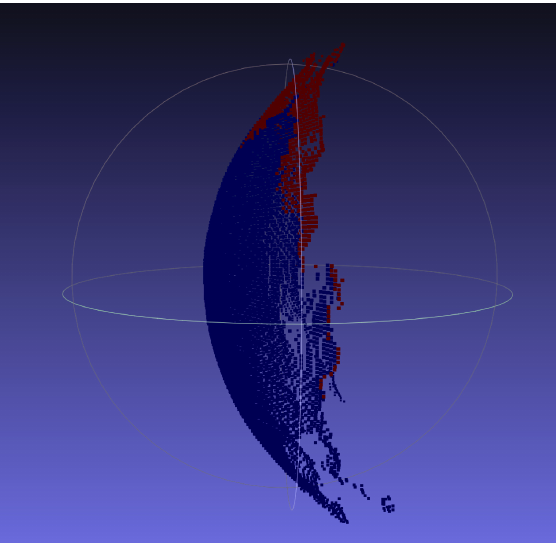
Figure 9. Visualization of the sphere of experiment 1 already adjusted in Meshlab.